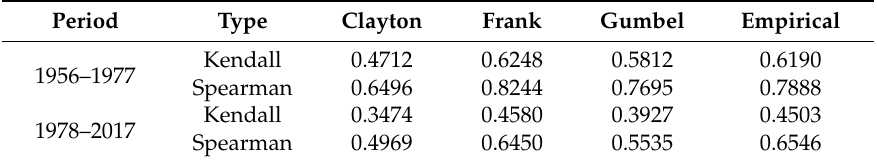
Figure 4. The univariate p -III distribution of annual runoff subseries of two tributaries during the pre-change and post-change periods. ( a ) Annual runoff distribution at Houbi (Hb) section; ( b ) Annual runoff distribution at Kuangmenkou (Kmk) section. Table 5. Comparison of rank correlation coefficient for copulas.